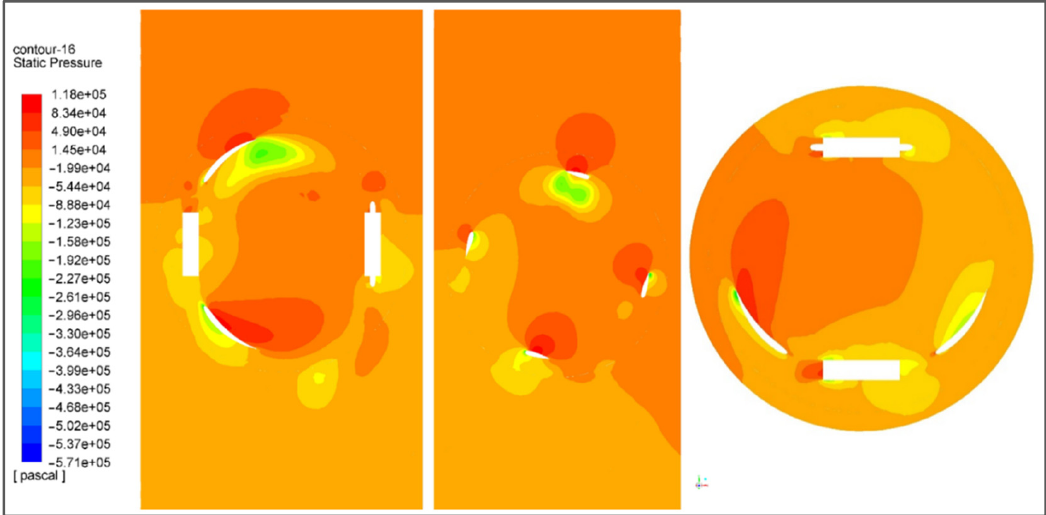
Figure 18. Pressure contour of the turbine showing the variation in pressure along with the mesh. Turbulent kinetic energy (TKE) is the mean kinetic energy per unit mass associated with eddies in the turbulent flow of the fluid. Physically, the turbulence kinetic energy is characterized by measured root-mean-square (RMS) velocity fluctuations. The turbulent kinetic energy of the fluid and kinetic energy due to buoyancy are together responsible for turbine operation but in a vertical pipe turbulent kinetic energy is much greater than kinetic energy due to buoyancy. The turbulent kinetic energy contour shown in Figure 19 represents the change in TKE of the fluid at different positions of the fluid flow.